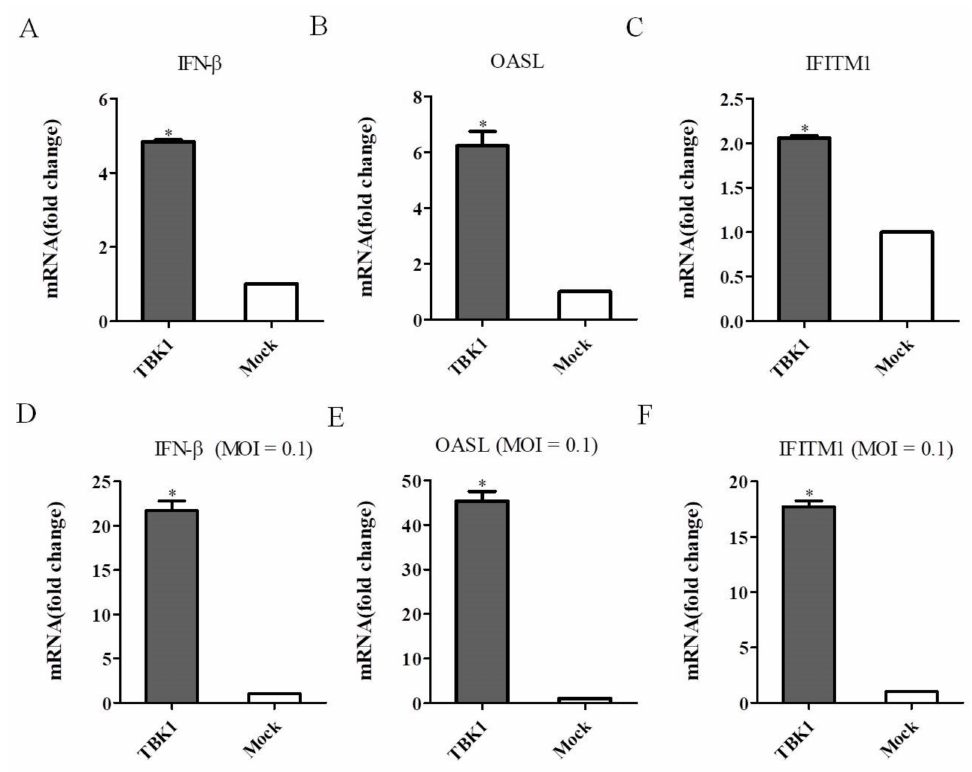
Figure 6. IFN- β and ISGs expression levels in DEF cells. ( A – C ) DEF cells were transfected with pCAGGS-TBK1 expressing TBK1 for 48 h and IFN- β , OASL and IFITM1 expression levels were detected by qRT-PCR. ( D – F ) DEF cells were transfected with pCAGGS-TBK1 expressing TBK1 for 24 h, and then infected with DEV at a MOI of 0.1. DEF cells were then collected and IFN- β , OASL and IFITM1 expression levels were detected by qRT-PCR. Significant differences in IFN- β , OASL and IFITM1 expression levels between TBK1-transfected and mock-transfected DEF cells were assessed using the Student’s t-test. Mean ± SD of three technical replicates are shown. * p <